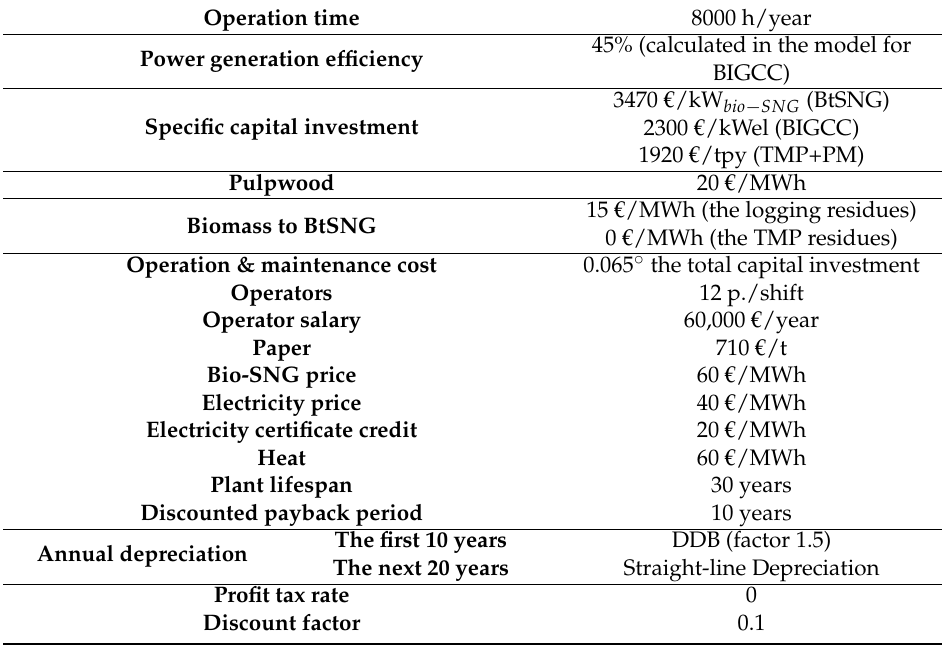
Table 3. Data for economic analysis [3,7,11,19,20]. BIGCC: biomass integrated gasification combined cycle; DDB: Double-Declining Balance